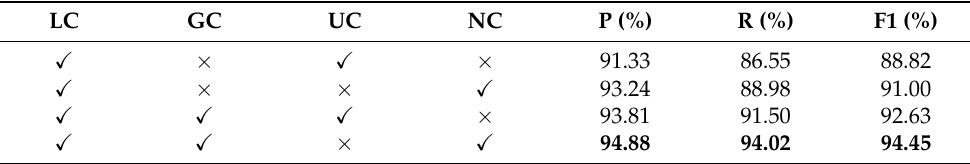
Table 4. Ablation study of our RegCD-Net on our dataset. Ablations are local correlation (LC), global correlation (GC), Unet connection (UC) and nested connection (NC). All of the following models do not add